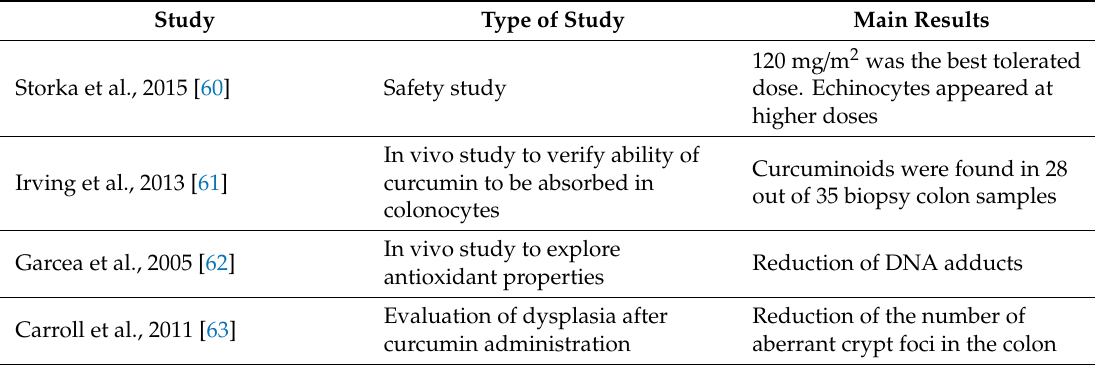
Table 1. The main human studies that investigating curcumin e ff ect in colorectal